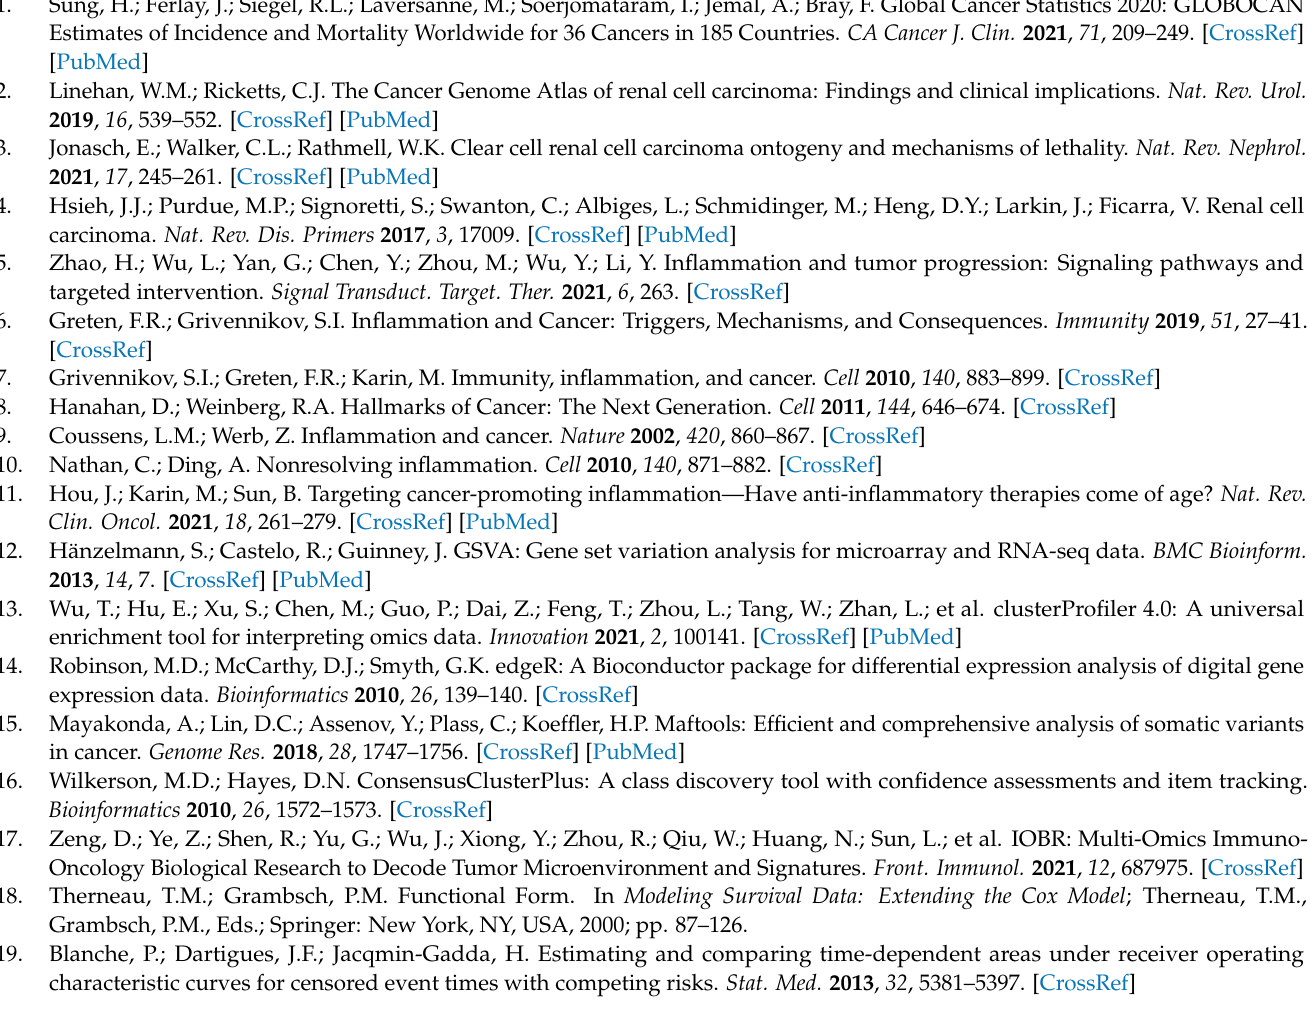
Table S1. The differences in the SNVs between high- and low-risk